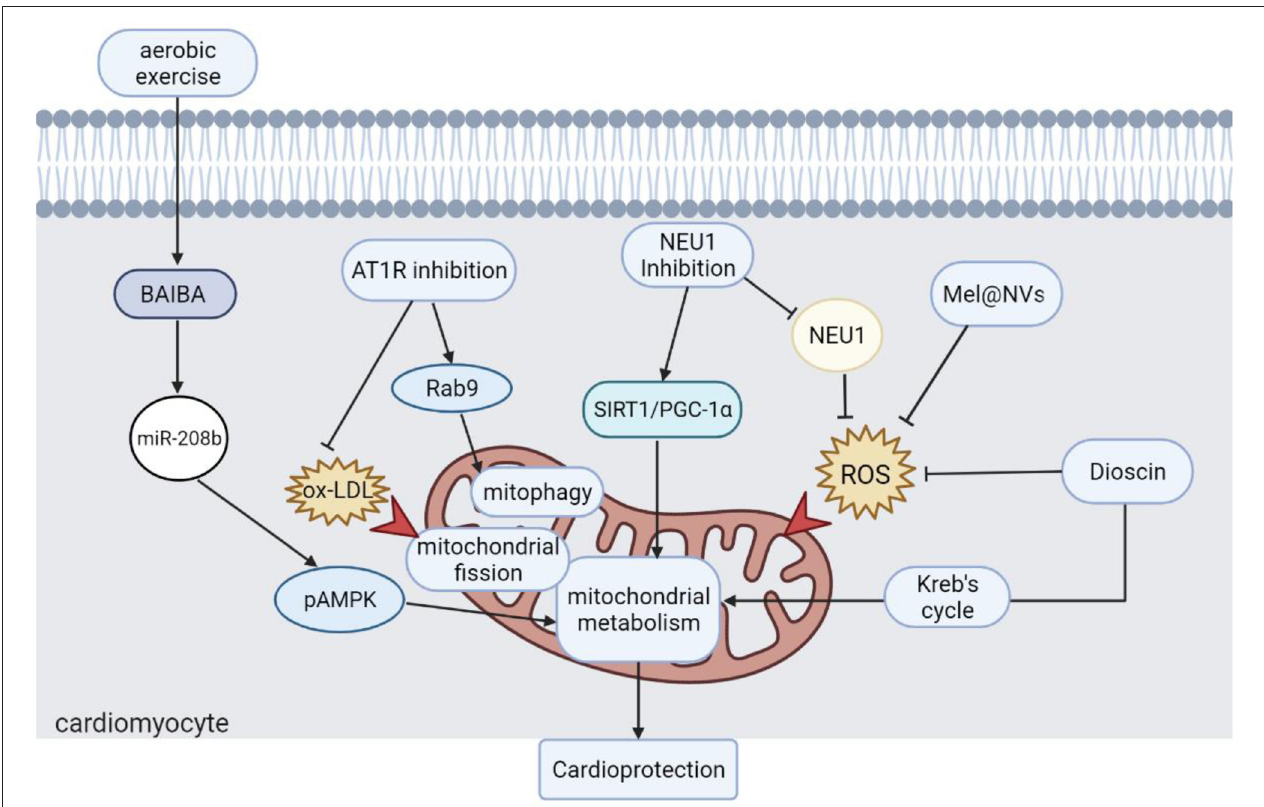
FIGURE 1 | Strategies for mitochondria-targeted IHD therapy. Moderate aerobic exercise is an effective strategy to protect heart function. Different approaches to restore mitochondrial dynamics, autophagy, and metabolism are effective strategies for the treatment of IHD. Scavenging ROS accumulation is also one of the ways to restore mitochondrial function, which also plays a positive role in the recovery of cardiac function. BAIBA, β -Aminoisobutyric Acid; pAMPK, AMPK phosphorylation; AT1R, angiotensin II type 1 receptor; ox-LDL, oxidized low-density lipoprotein; Drp1, dynamin-related protein 1; NEU1, neuraminidase 1; SIRT1, sirtuin-1; PGC-1 α , peroxisome proliferator-activated receptor γ coactivator α ; Mel@NVs, melatonin engineered NVs; ROS: reactive oxygen